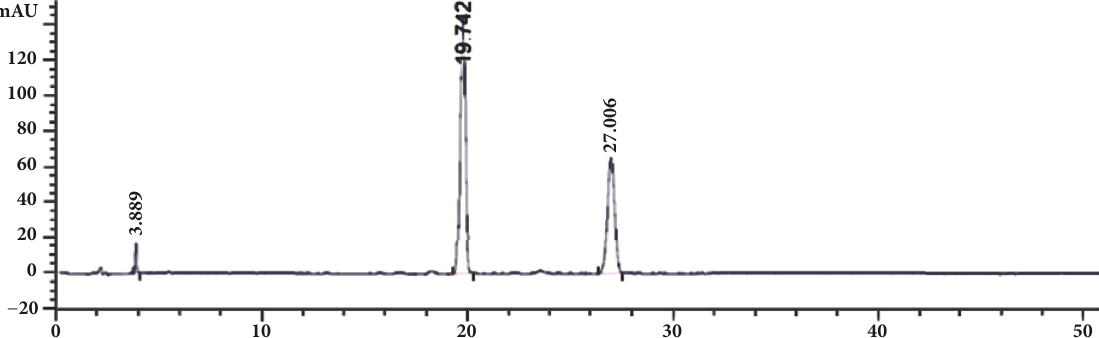
Figure 2: HPLC profile of the SC-CO 2 extract of the leaves of P. frutescens var. crispa (cv. Antisperill) at 254nm. Peak 1: 9-hydroxy isoegomaketone ( 1 ); peak 2: isoegomaketone ( 2 ); peak 3: perilla ketone ( 3 ) (for chromatography conditions, see Section